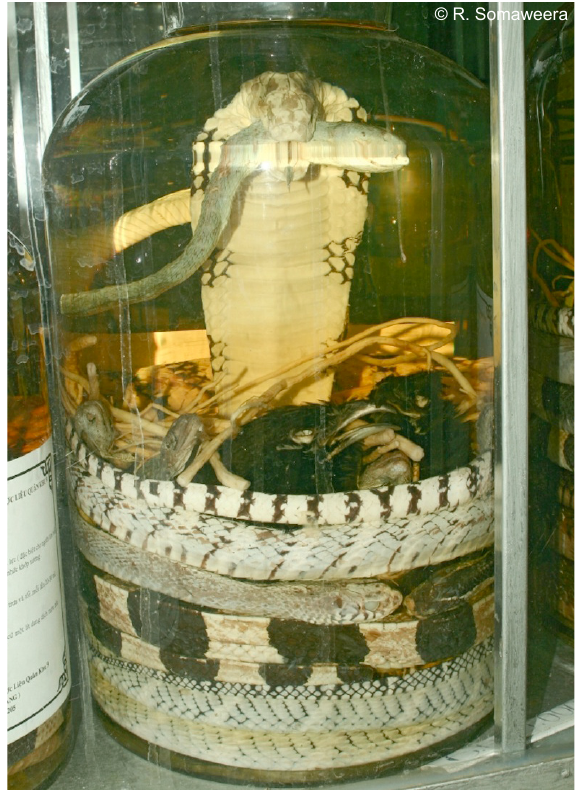
Image 7. An over 5l bottle containing a King Cobra as the main subject with a pit-viper hanging from the mouth. The base contains rat snakes and a Banded Krait while Tokay Geckos, birds and ginseng roots are also used as items. In certain Chinese cultures it is considered that Indo-Chinese rat snakes, cobras and kraits will benefit the upper, middle and lower portions of the body,